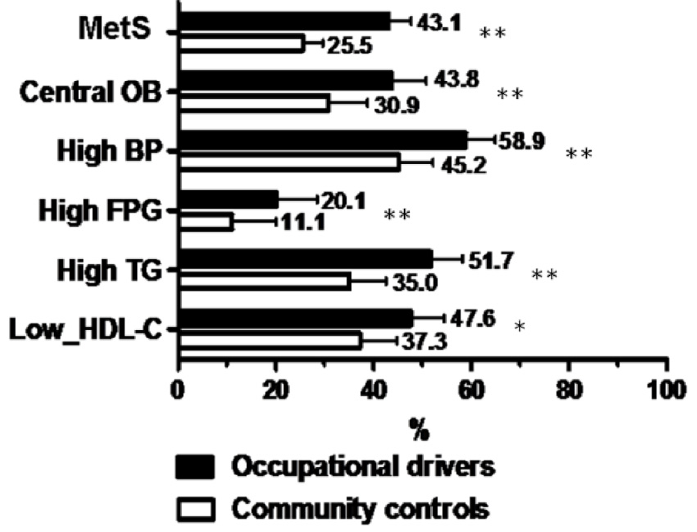
Figure 1. Prevalence of metabolic syndrome (MetS) and its components in occupational drivers and community controls. OB: obesity; BP: blood pressure; FPG: fasting